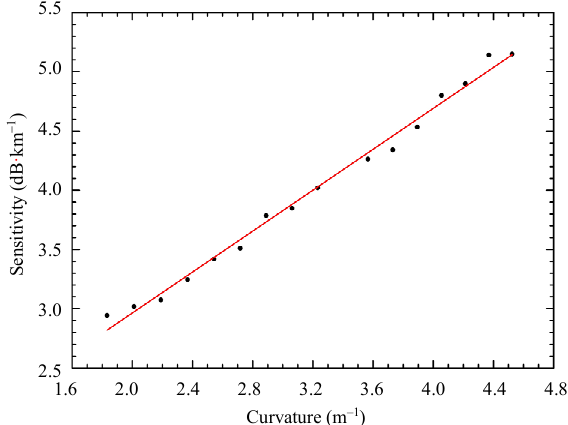
Fig. 5 Sensitivities measured in the OTDR along the applied